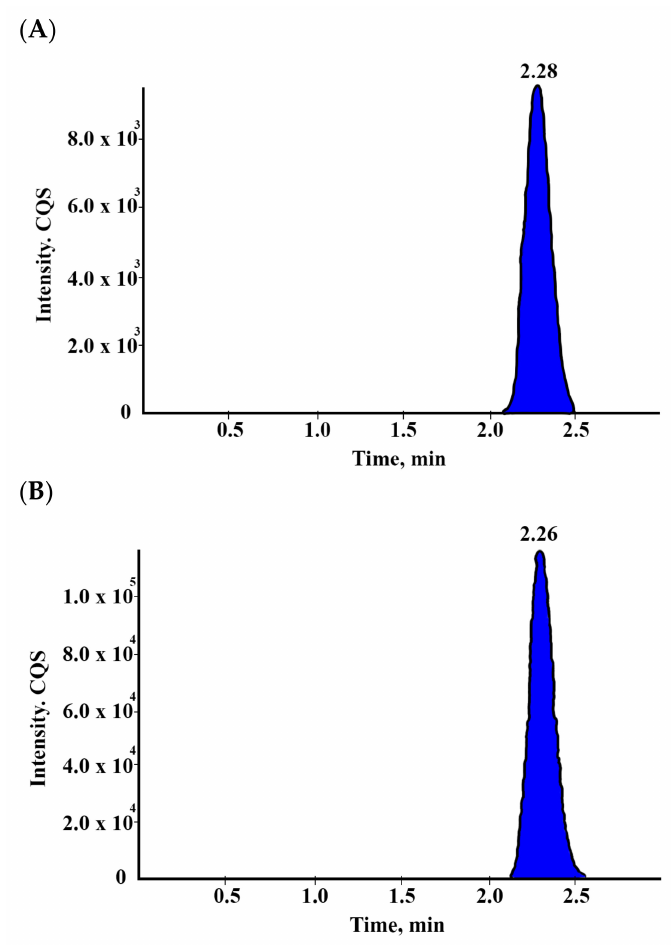
Figure 2. Chromatograms of the empagliflozin test ( A ) and parent reference ( B ) were 2.28 and 2.26,